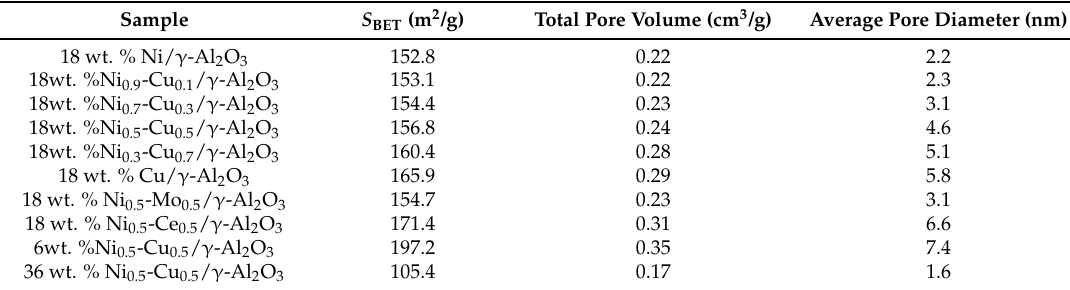
Table 1. Surface area and pore structure of different catalysts.